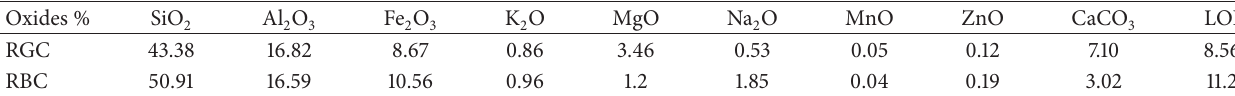
Table 2: Chemical characteristics of raw clays (in mass %).